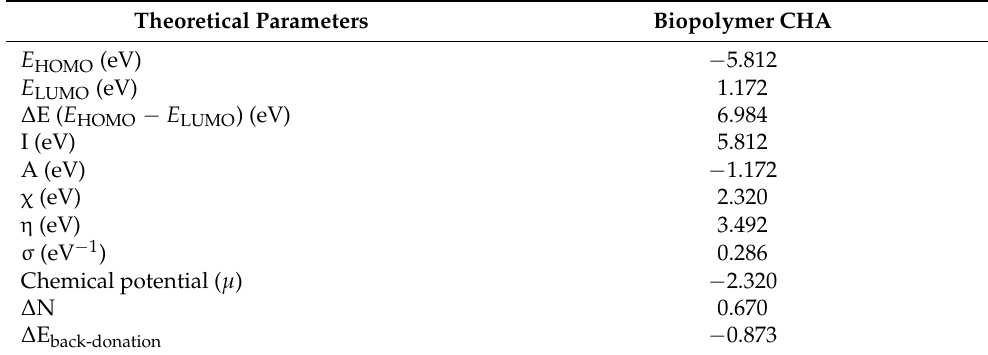
Table 5. Calculated theoretical parameters for the biopolymer CHA molecule present in the leaves and stems of Artemisia herba-alba